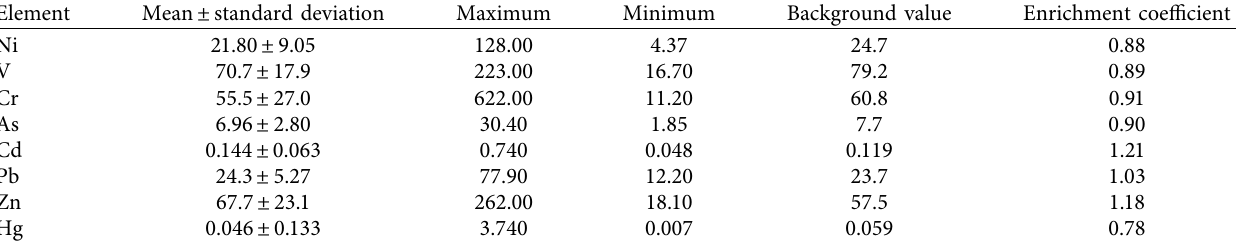
Table 2: Statistics of soil heavy metal content in the research area ( W